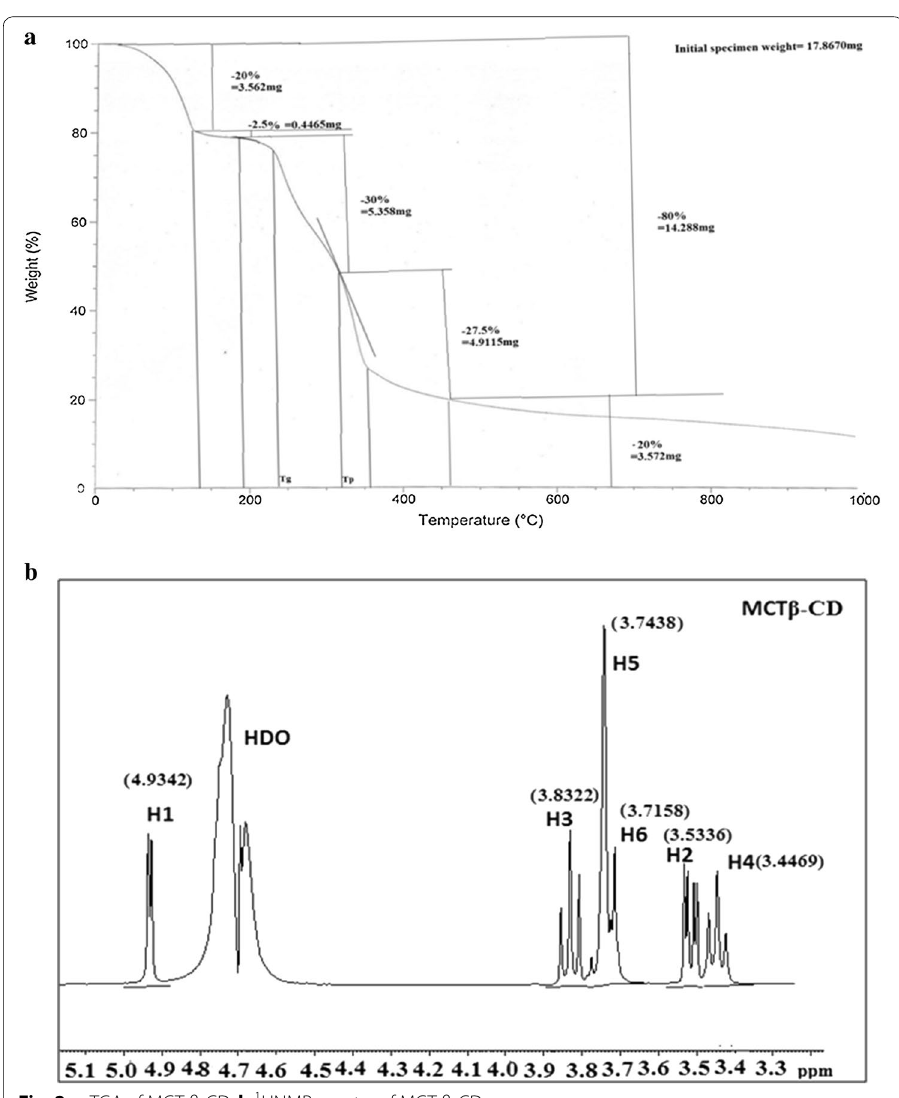
Fig. 2 a TGA of MCT β-CD; b 1 HNMR spectra of MCT